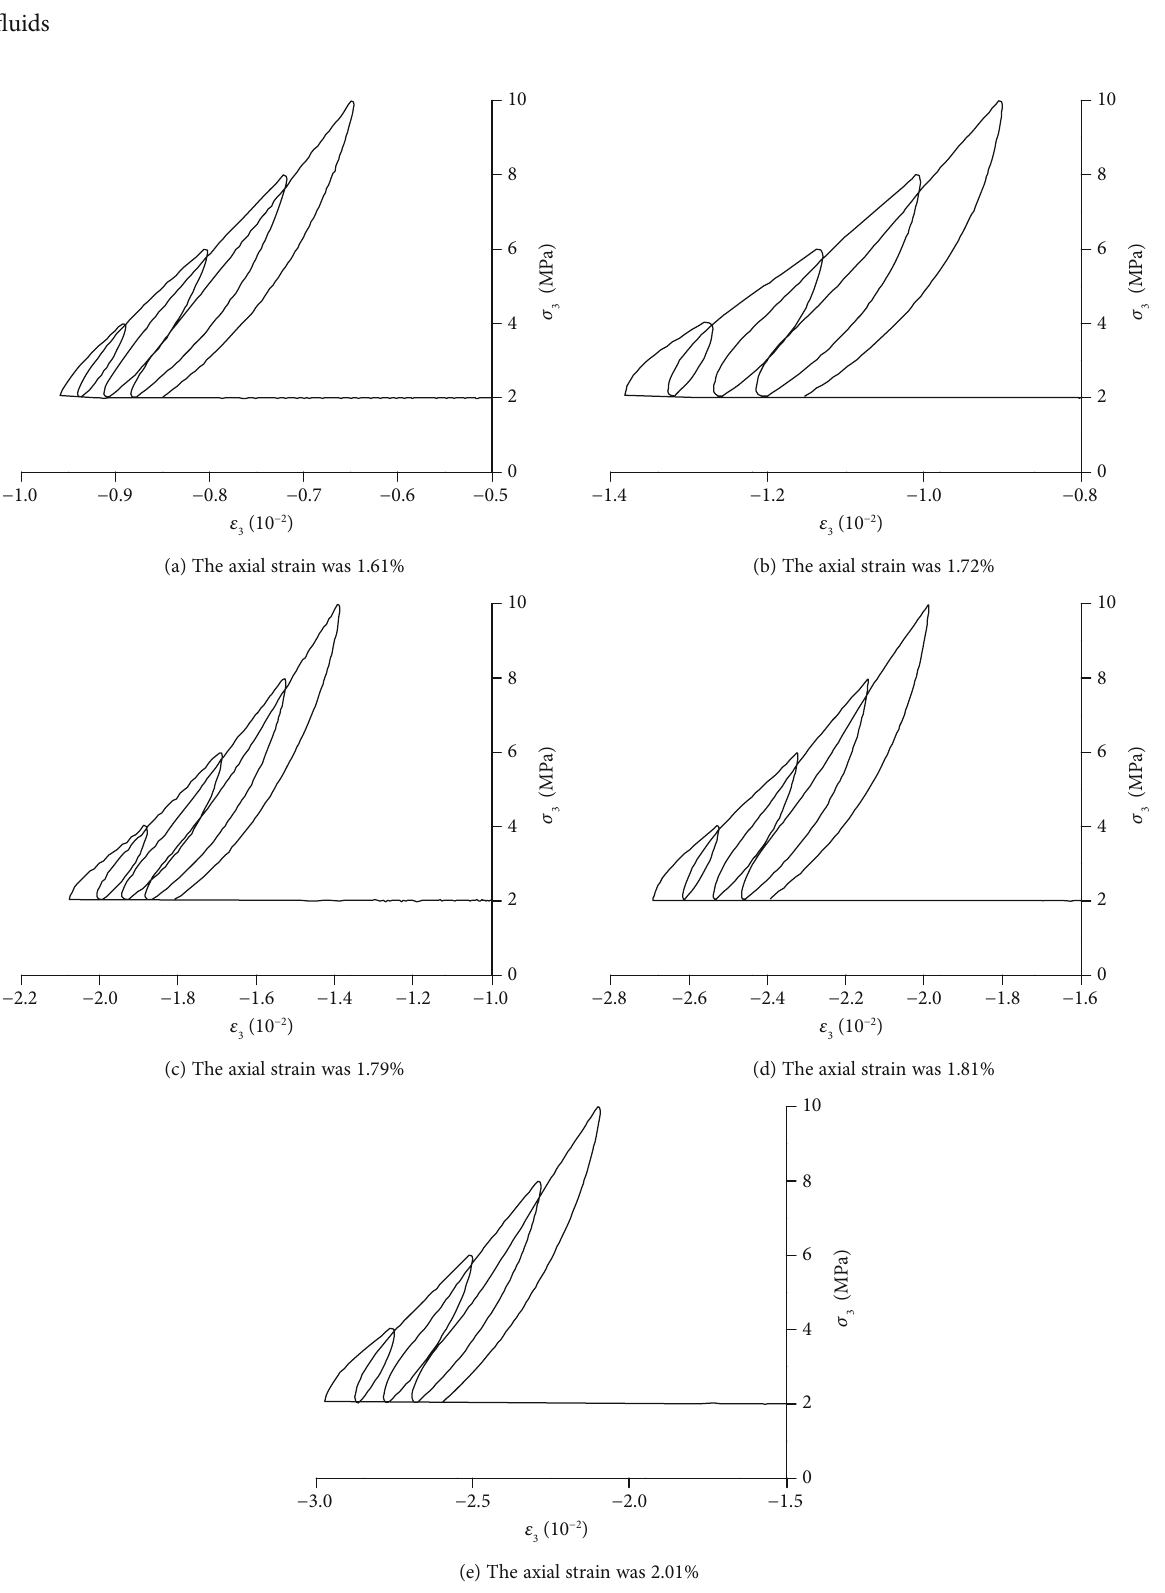
Figure 13: The circumferential strain-circumferential stress curve of water-bearing coal specimens under constant axial